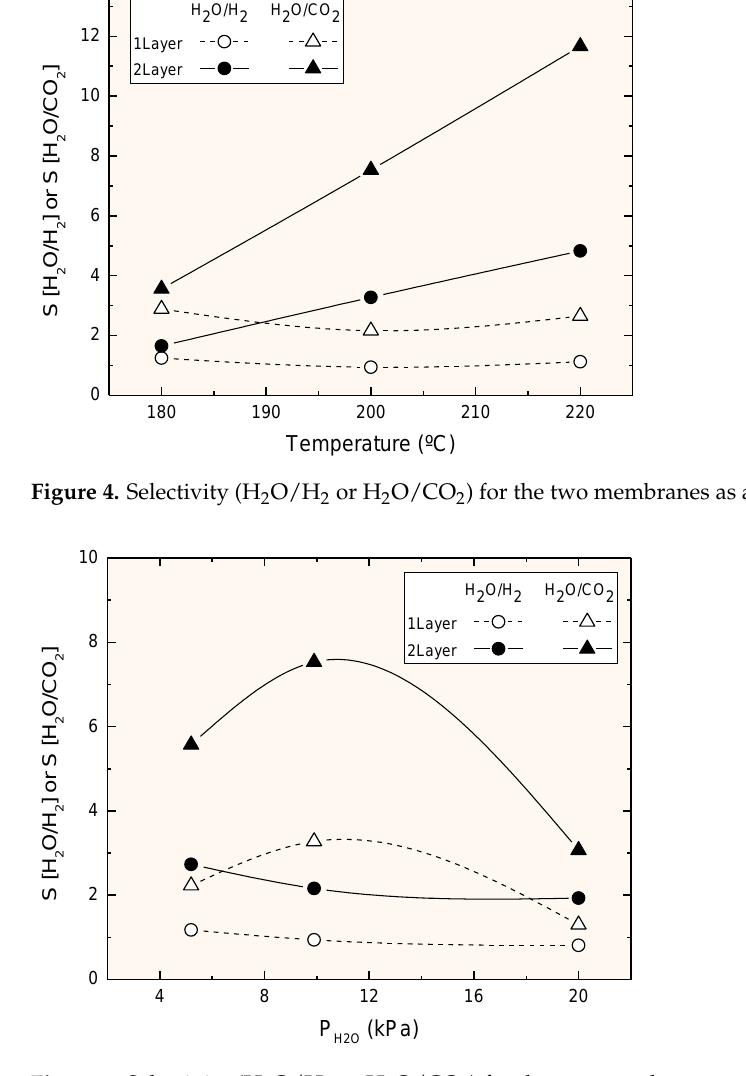
Figure 5. Selectivity (H 2 O/H 2 or H 2 O/CO 2 ) for the two membranes as a function of water partial pressure.